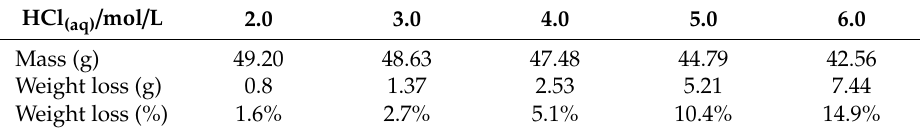
Table 2. The weight loss of spent catalysts at di ff erent concentrations of